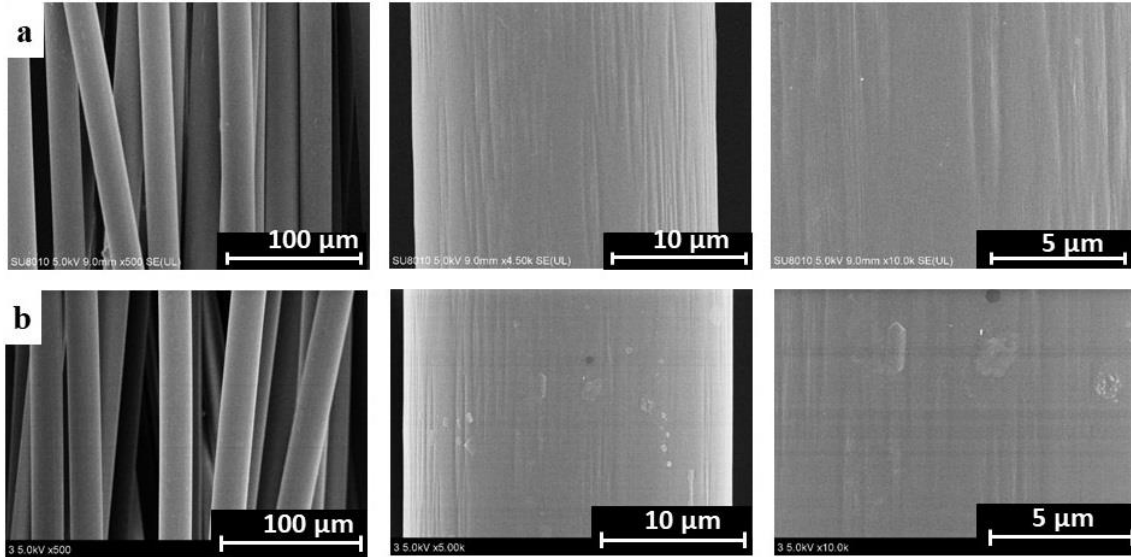
Figure 15. SEM micrograph of ( a ) the regenerated and ( b ) the stabilized reverted nylon 6,6 fibres.